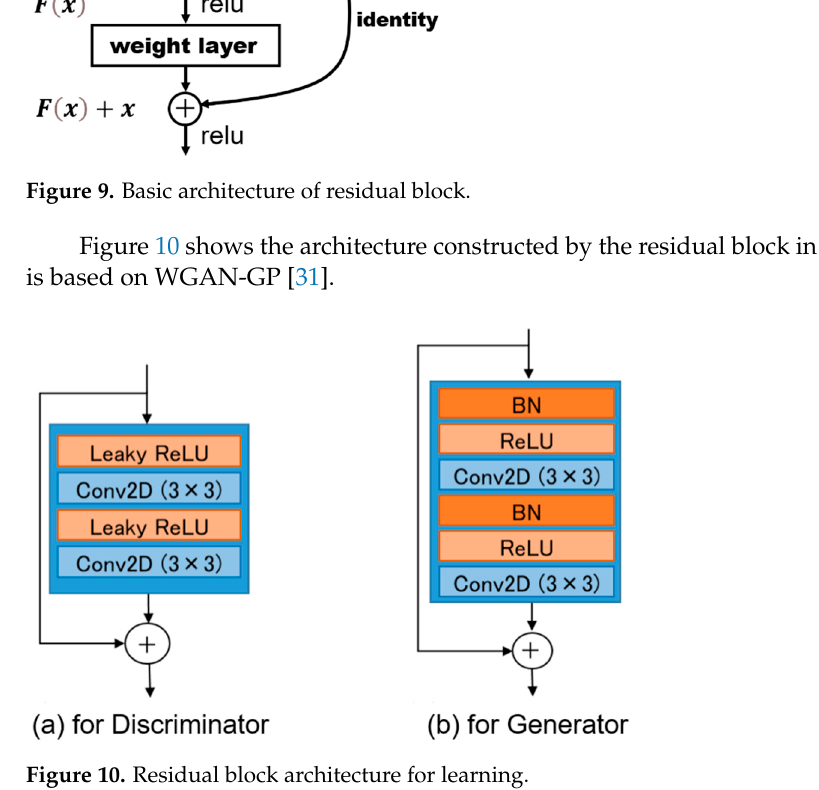
Figure 10. Residual block architecture for learning.